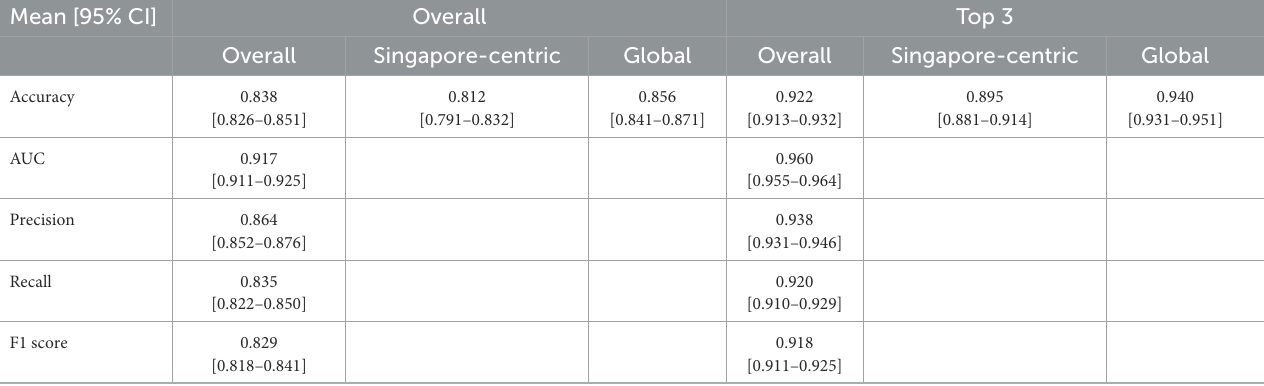
TABLE 1 Performance assessment for DR-COVID question-answer retrieval for overall and top 3 results, across both Singapore-centric and global questions.